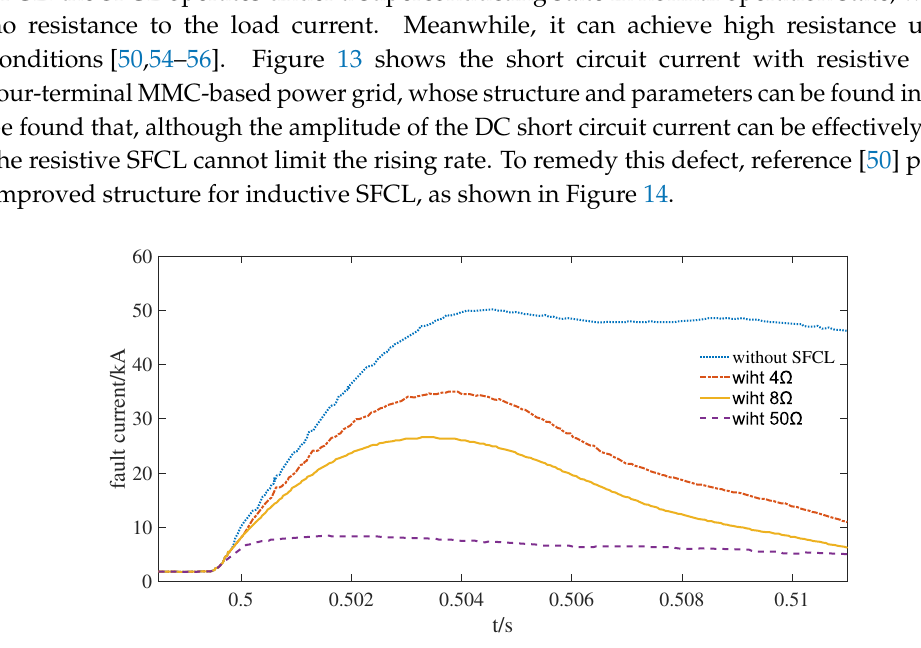
Figure 13. Short circuit current with the resistive